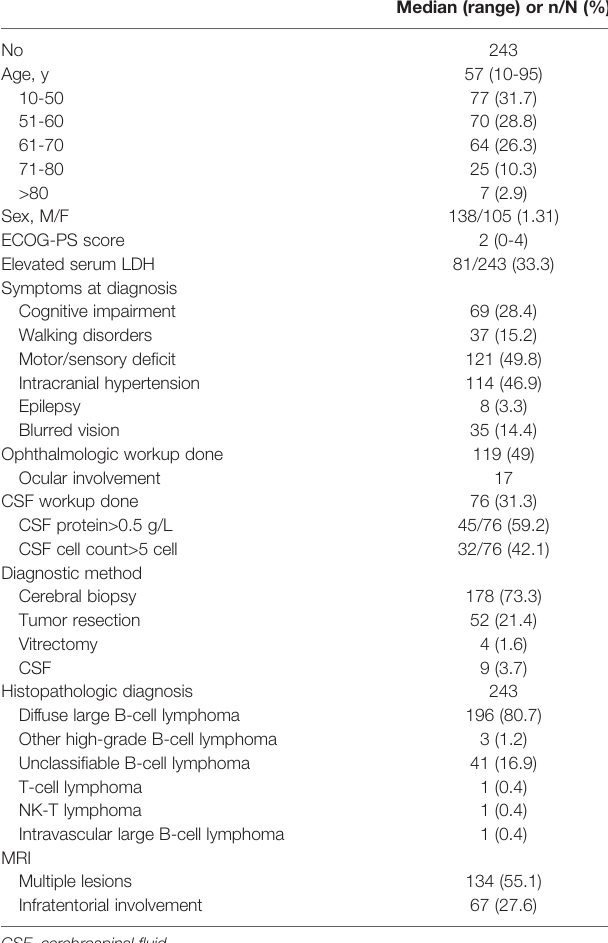
TABLE 1 | Main characteristics at diagnosis.